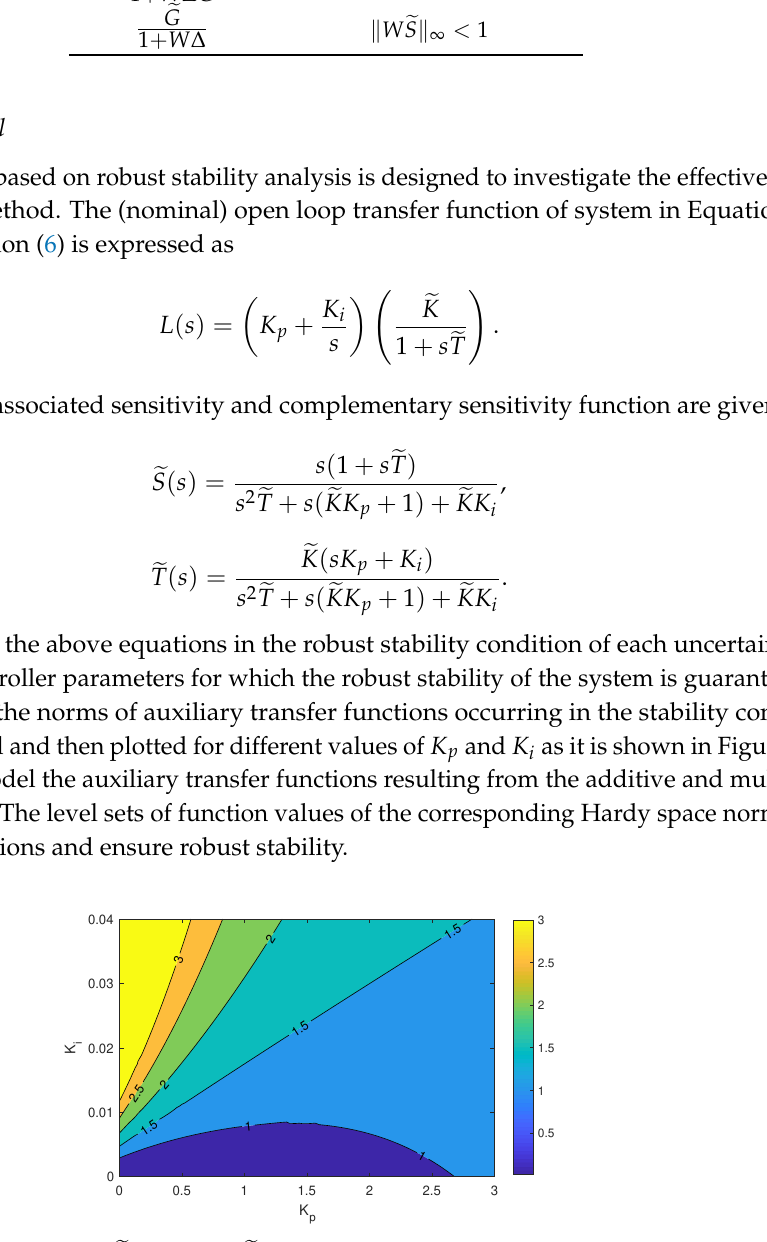
Figure 7. Level sets of (cid:107) WC (cid:101) S (cid:107) ∞ and (cid:107) W (cid:101) T (cid:107) ∞ for different values of K p and K i for the system with additive and multiplicative